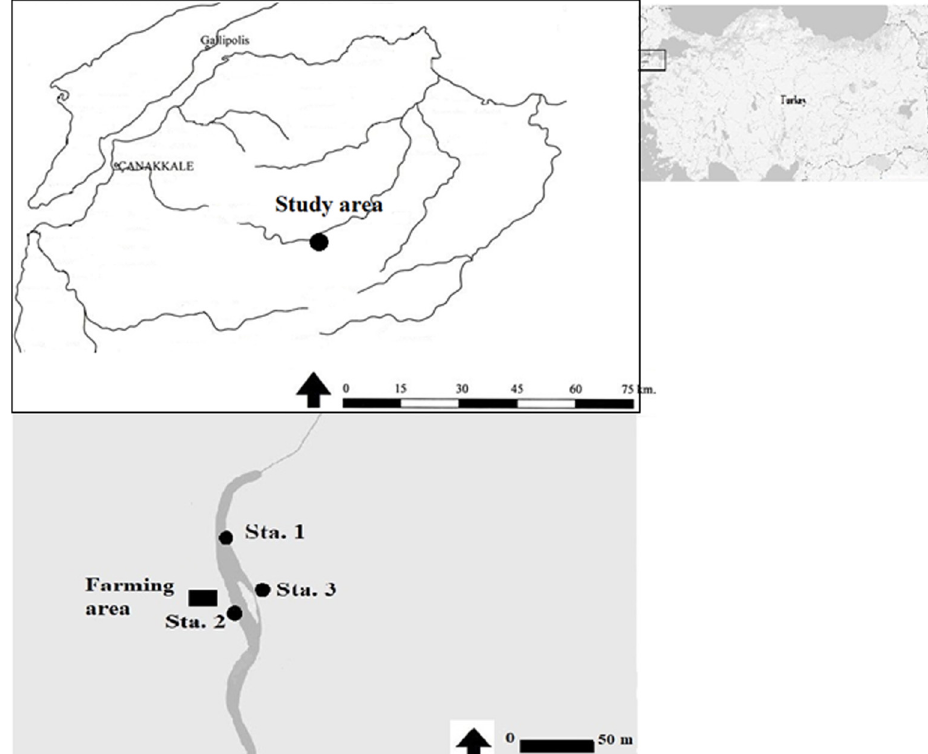
Fig 1. The study area with the three sampling stations. Flow direction is from station 1 to station